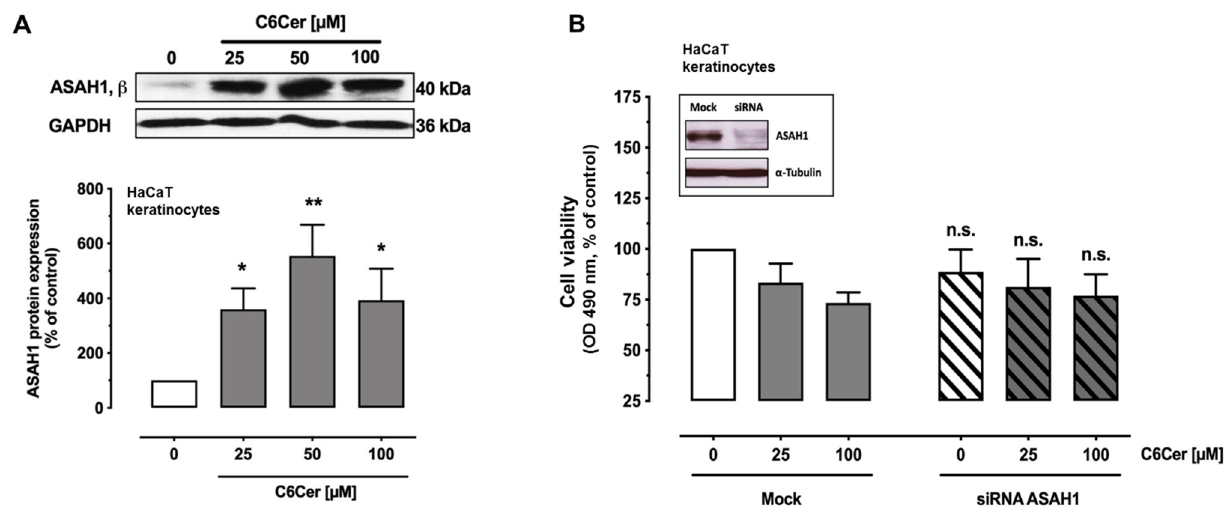
Figure 4. The role of acid ceramidase 1 in C6 ceramide metabolism. ( A ): HaCaT cells were treated with C6 ceramide (C6Cer) or vehicle for 24 h and protein level of ASAH1 β chain was determined by Western Blot. ( B ): Cells were treated with ASAH1- or mock small interfering RNA (siRNA) for 24 h. After incubation cells were treated with C6Cer or vehicle for 24 h. Then cell viability was measured by MTS assay and normalized to the value of the vehicle-treated mock group. The success of knockdown was proven by Western Blot analysis. Data are shown as means ± SEM ( n = 3–4), * p < 0.05, ** p < 0.01. * and ** in A: Significantly different compared to the control group; n.s. in B: Not significantly different compared to the related mock-treated group.